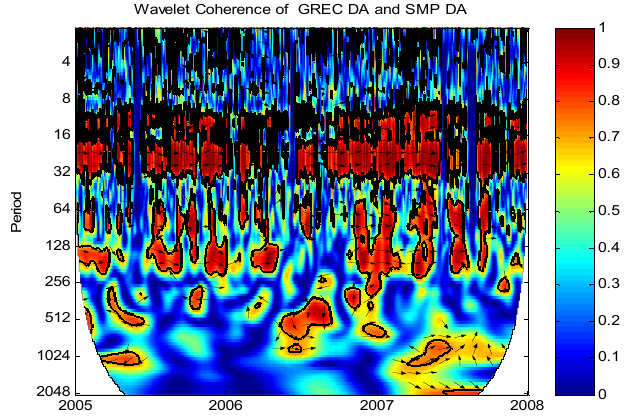
Figure 14. Wavelet coherence of GREC and SMP for period 2005–2007. The horizontal axis shows time, while the vertical axis shows the scale or period in hours. The warmer the colour of a region, the higher the degree of dependence or coherence between the two